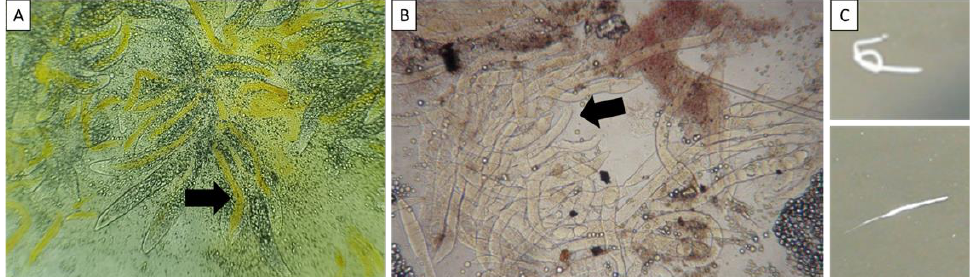
Figure 1. Squash mounts of the hepatopancreas ( A ) and intestinal tissue ( B ) of the WFS-affected shrimp observed under a light microscope, showing an accumulation of aggregated, transformed microvilli (arrow). White fecal strings floating on the water surface of the affected pond ( C ). To date, the etiology of WFS has been proposed as the combination of EHP with opportunistic marine pathogens, including Vibrio spp. and Propionigenium sp. [1,11], but the experimental challenge using the individual pathogen cannot fulfill Koch’s